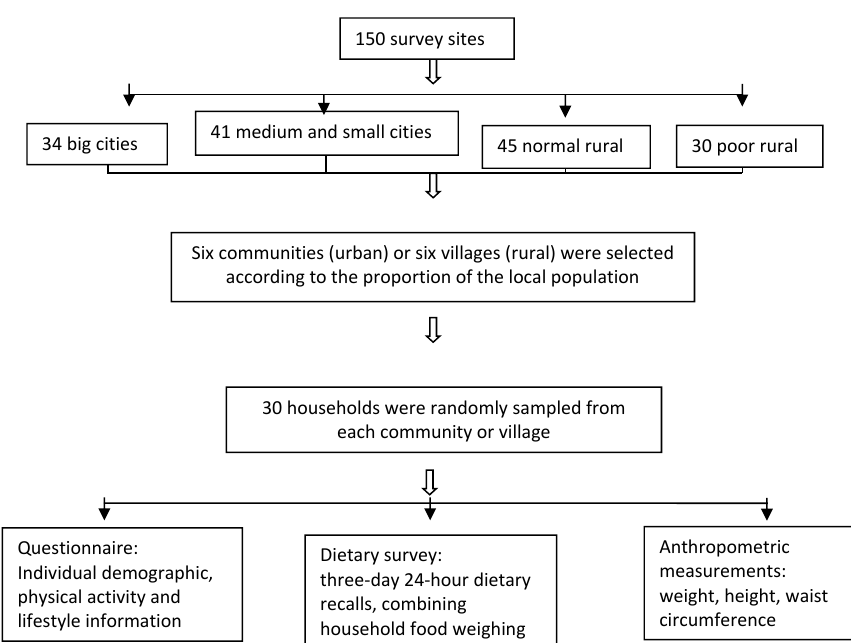
Figure1. Figure 1. The flow diagram of the China National Nutrition and Health Survey (CNNHS) during 2010–2012.